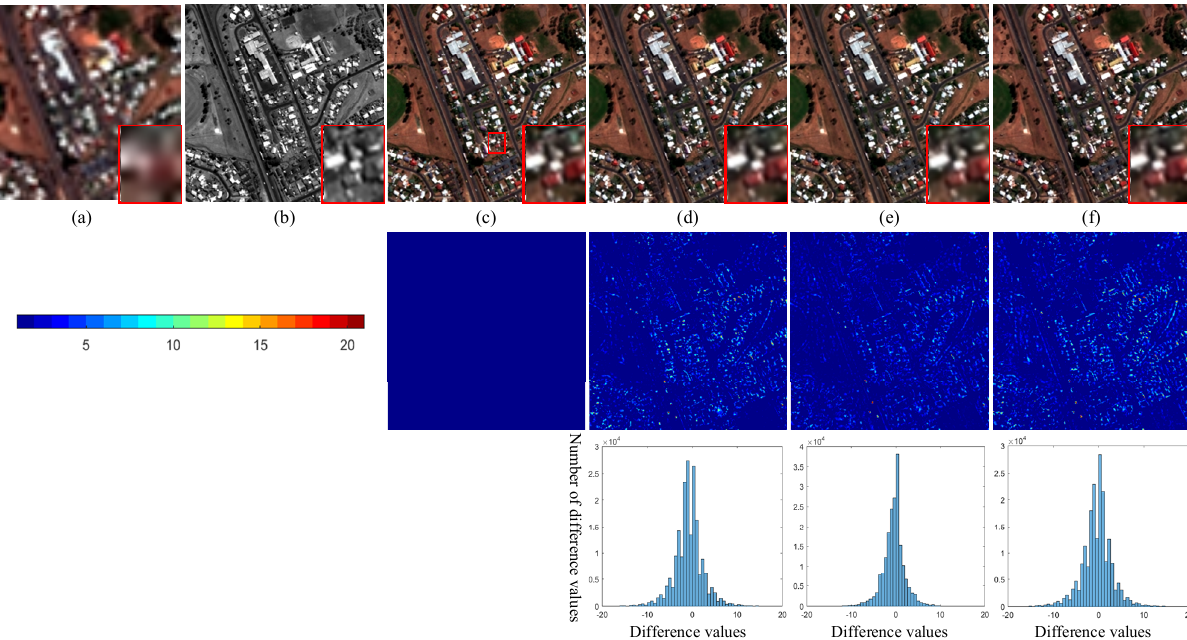
Figure 12. Influences of different architectures on the GeoEye-1 dataset. ( a ) LR MS image; ( b ) PAN image; ( c ) reference image; ( d ) 2 CT encoders; ( e ) 3 CT encoders (MSIT); ( f ) 4 CT encoders.